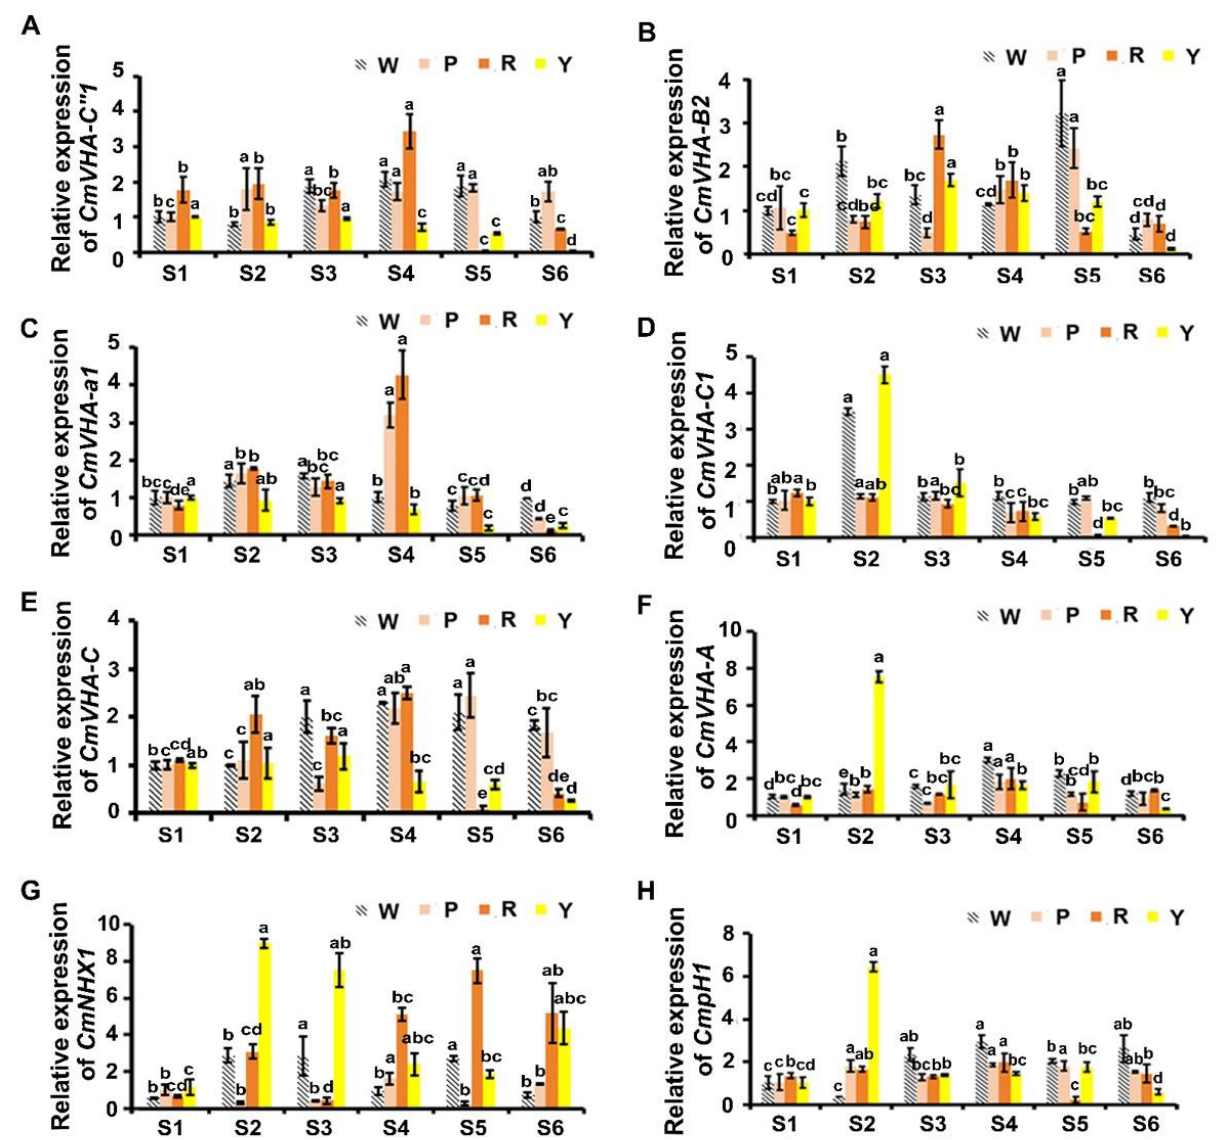
Figure 6. The relative expression of genes associated with vacuolar pH in chrysanthemums. ( A – H ) The relative expression of CmVHA-C”1 , CmVHA-B2 , CmVHA-a1 , CmVHA-C1 , CmVHA-C , CmVHA-A , CmNHX1 , and CmpH1 in ray florets of four colored chrysanthemums at six flowering stages. Data are shown as the mean ± standard error of the mean, based on more than three replicates. Different letters indicate significant differences at p < 0.05 according to the Duncan’s multiple range test.